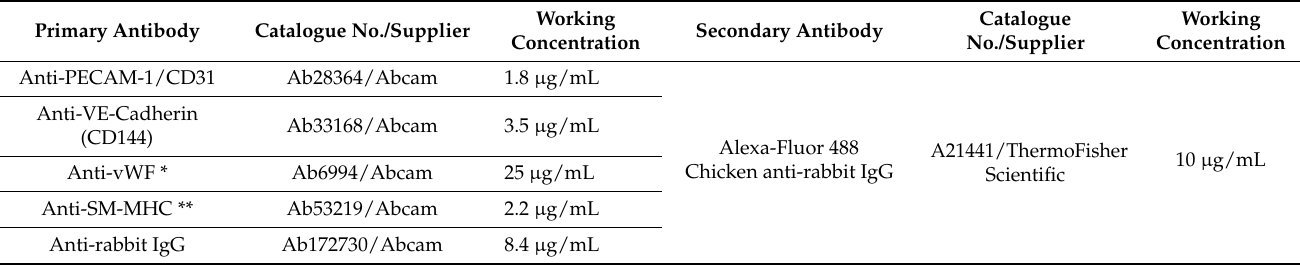
Table A3. Antibodies used for immunocytochemical